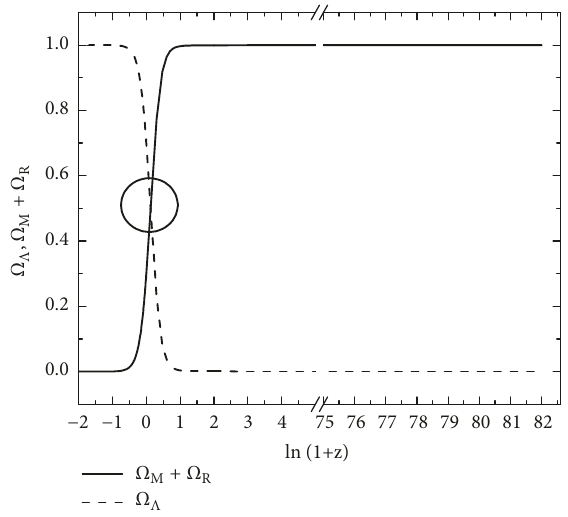
Figure 1: Standard coincidence problem in the cosmic concordance model ( Λ 0 CDM). Solid and dashed lines represent the evolution of ) and total matter-radiation ( Ω 𝑀 + Ω 𝑅 ) density the vacuum ( Ω Λ 0 parameters. The circlemarks the low (and unique!) redshift present- ing the extreme coincidence between the density parameter of the vacuum and material medium. Note that the model discussed here is fully equivalent to Λ 0 CDM when the time dependent corrections in the decay Λ(𝑡) expression are neglected [see